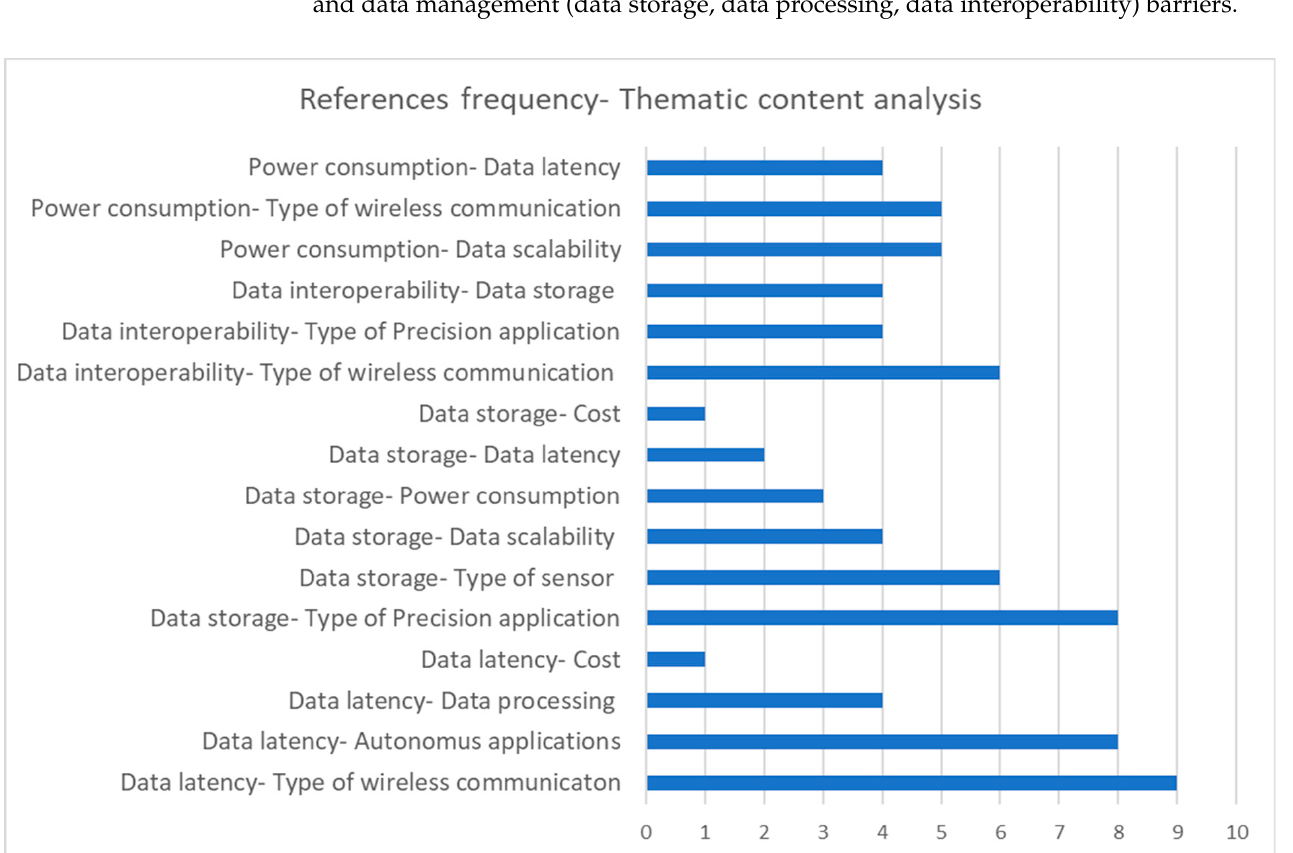
Figure 3. Frequency of text references identified in focus group interview transcripts.